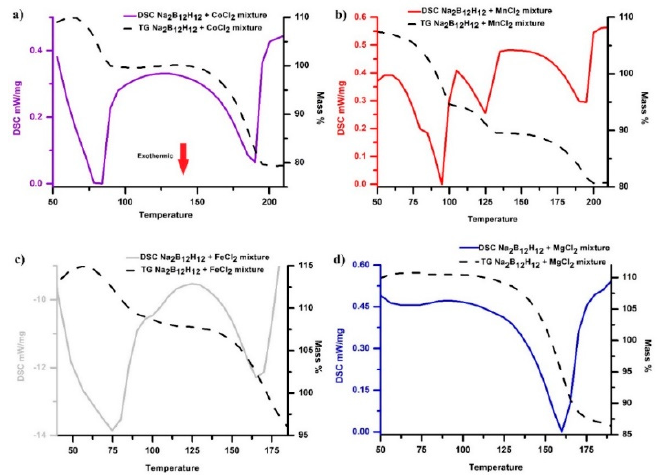
Figure 1. Di ff erential scanning calorimetry (DSC) / thermogravimetry (TG) heating curves for ball-milled and solvated with ethanol ( a ) Na 2 B 12 H 12 + CoCl 2 , ( b ) Na 2 B 12 H 12 + MnCl 2 , ( c ) Na 2 B 12 H 12 + FeCl 2 and ( d ) Na 2 B 12 H 12 + MgCl 2 mixtures. The samples were loaded in an open crucible to allow the removal of ethanol molecules. The samples were shortly exposed to air during the loading in the instrument, and adsorbed the humidity. This explains the starting TG values higher than 100%.